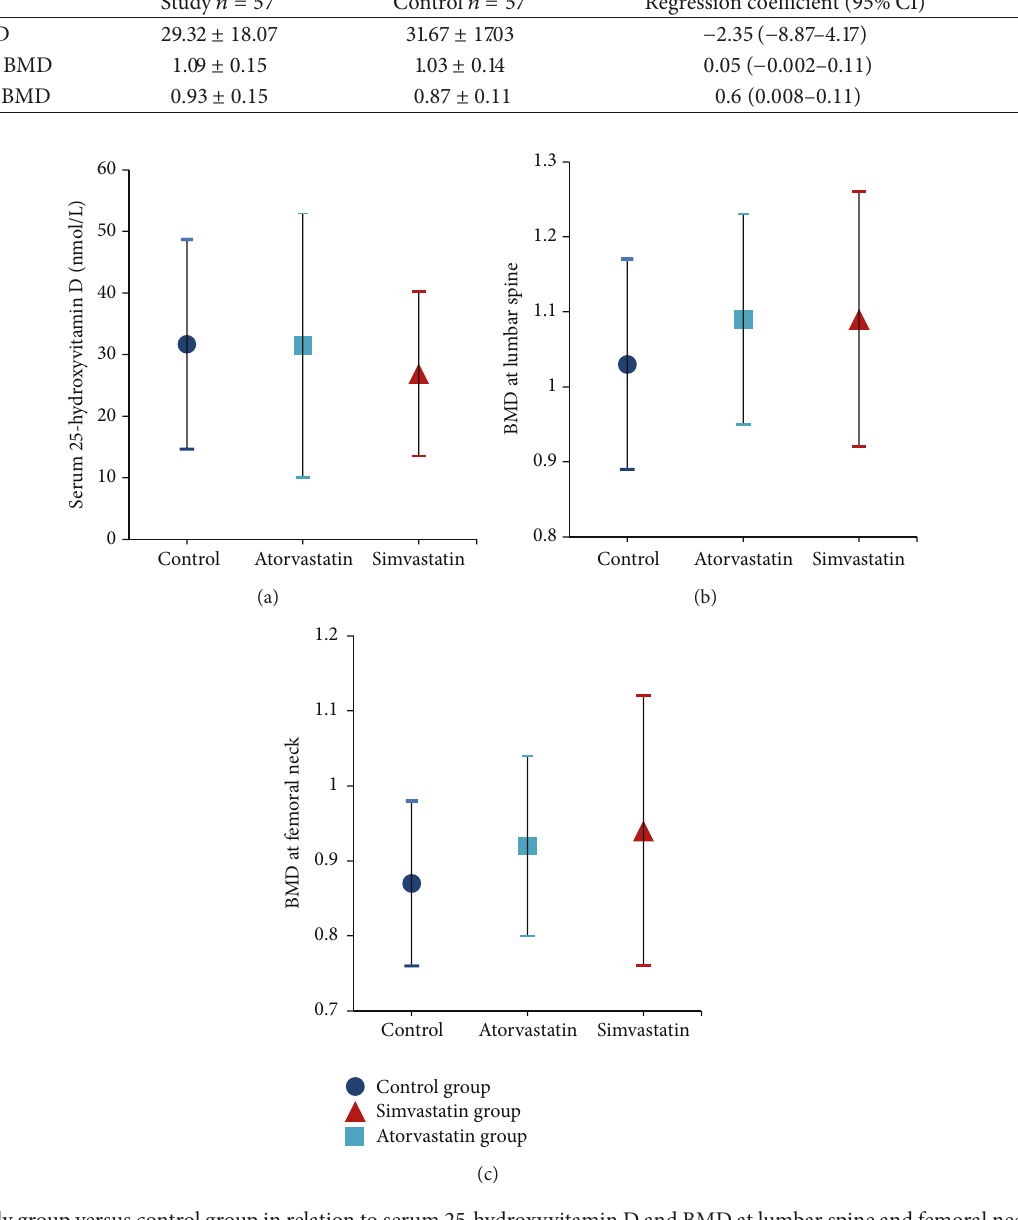
Figure 6: Study group versus control group in relation to serum 25-hydroxyvitamin D and BMD at lumbar spine and femoral neck (mean ± SD). BMD: bone mineral